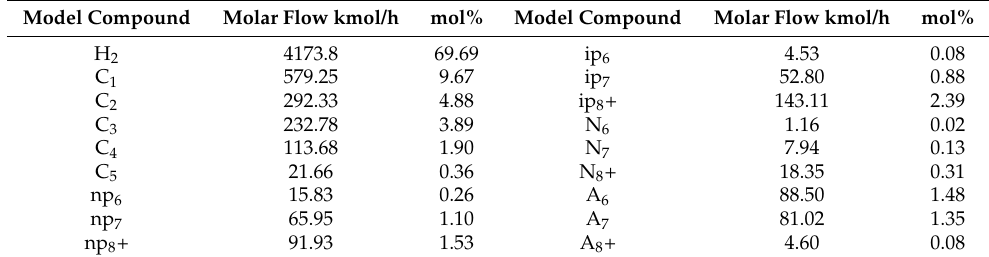
Table 4. Molar composition of the feed flow rate